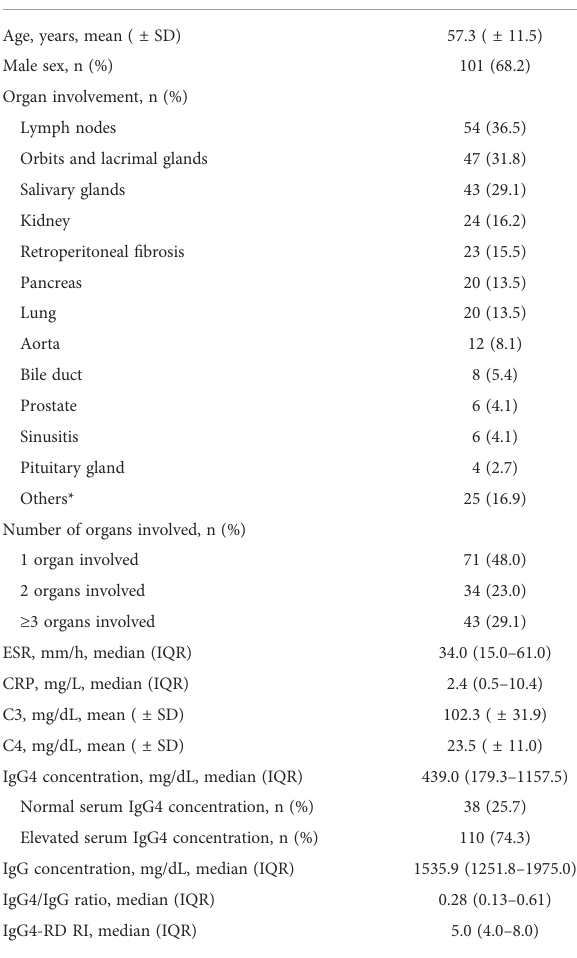
TABLE 1 Characteristics of the 148 patients diagnosed with IgG4- related